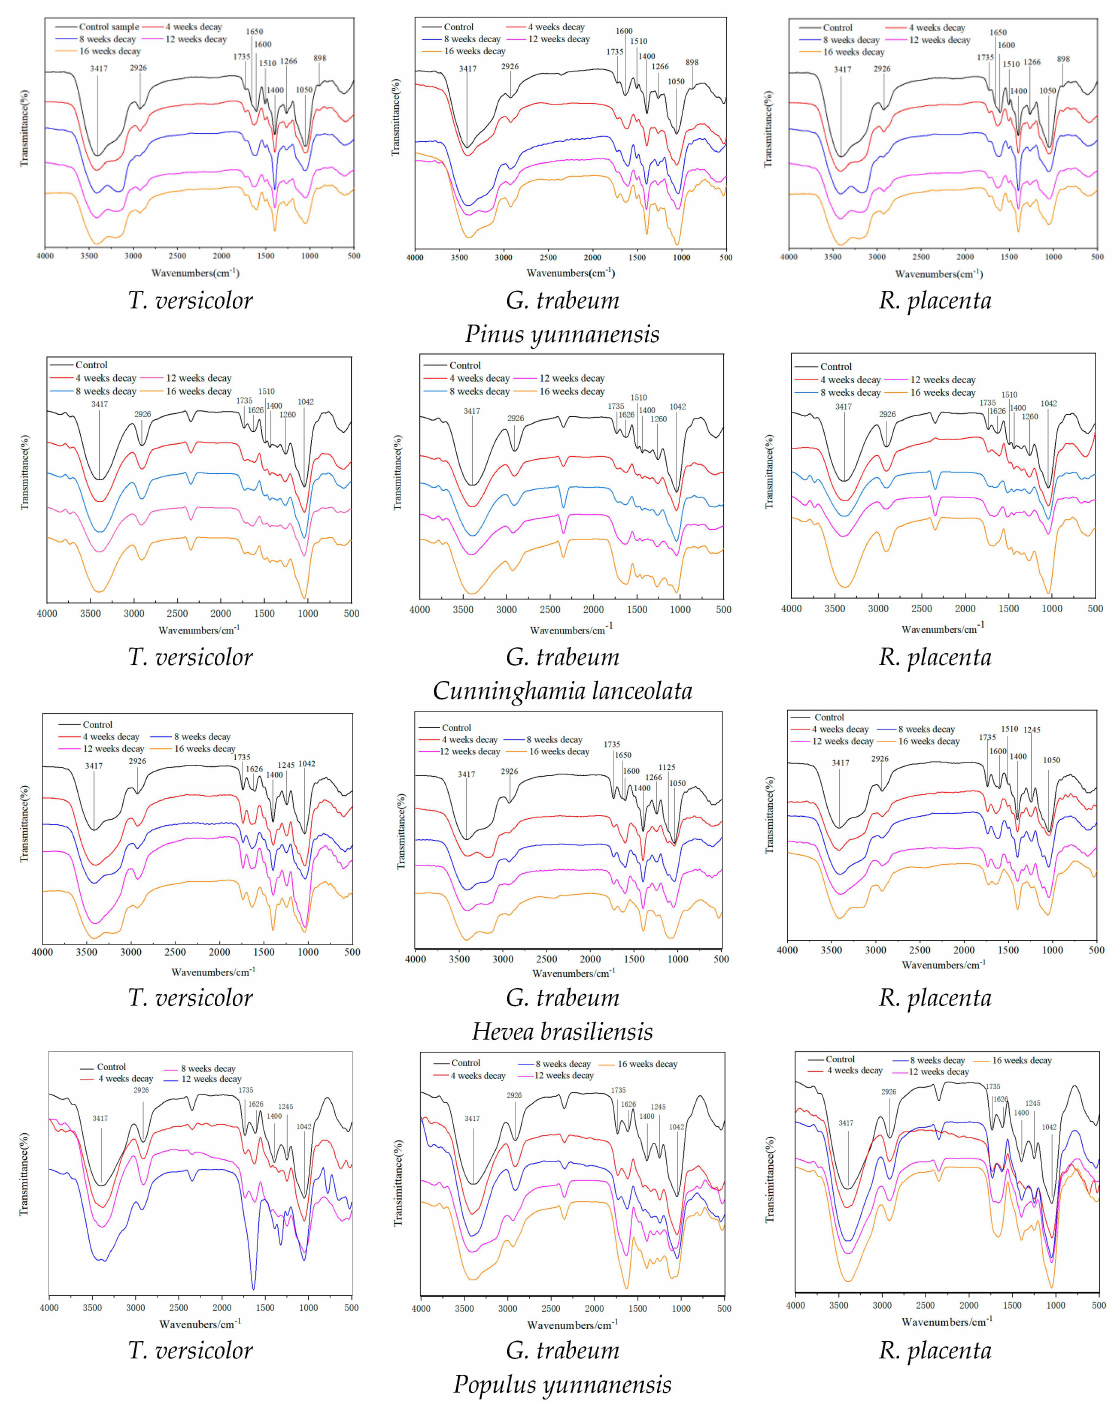
Figure 1. FT − IR spectra of wood samples biodegraded by different fungi. Results suggested that white rot fungus Trametes versicolor could attack lignin selec- tively and cause a selective conversion in softwood Pinus yunnanensis and Cunninghamia lanceolata , which could enhance the accessibility of cellulose to enzymatic digestibility, whereas it caused a simultaneous conversion in the hardwoods Populus yunnanensis and Hevea brasiliensis